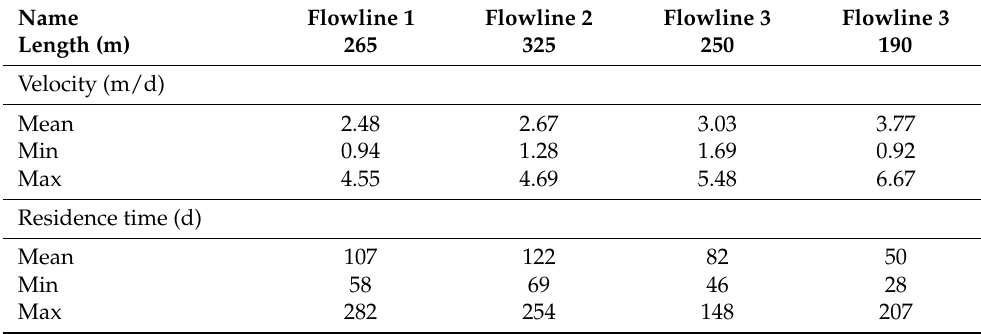
Table 2. Descriptive statistics of the average velocities calculated according to the main flow lines and associated residence times.